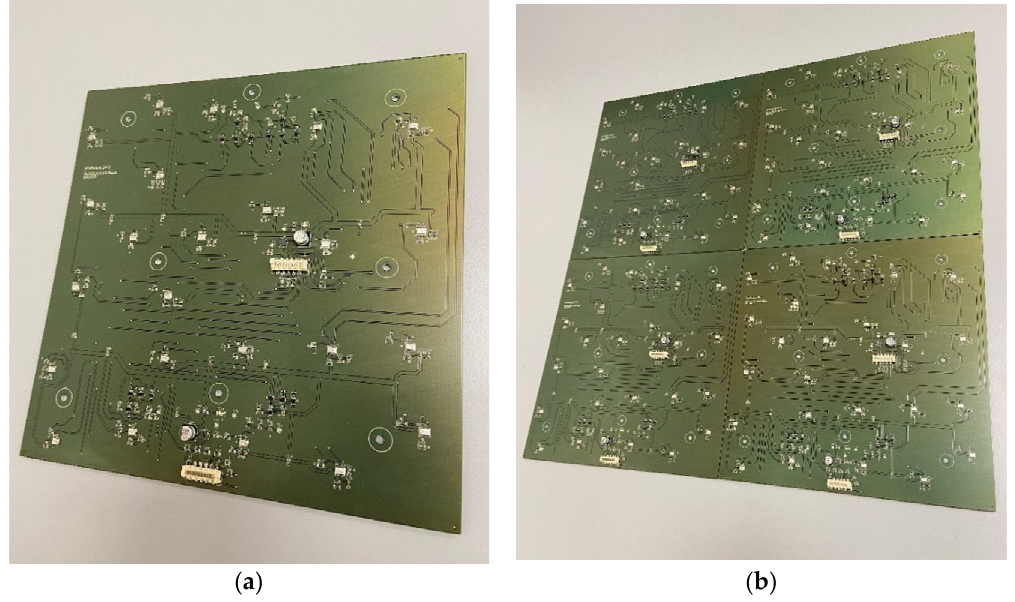
Figure 11. ( a ) A single printed circuit board with mounted electronic components for the prototype of plate-shaped acoustic camera; ( b ) Four boards arranged together to form Acoustic Camera 3 .